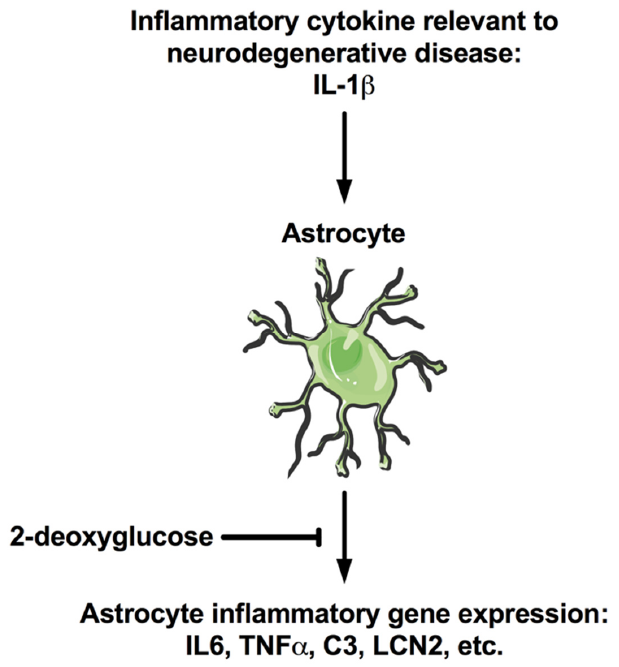
Figure 5. 2-DG blocks IL-1 β -induced inflammatory gene expression in human astrocytes. IL-1 β is a prototypic inflammatory cytokine that is relevant to many neurodegenerative diseases. IL-1 β was used here to model neuroinflammation while 2-DG was used to mimic caloric restriction,